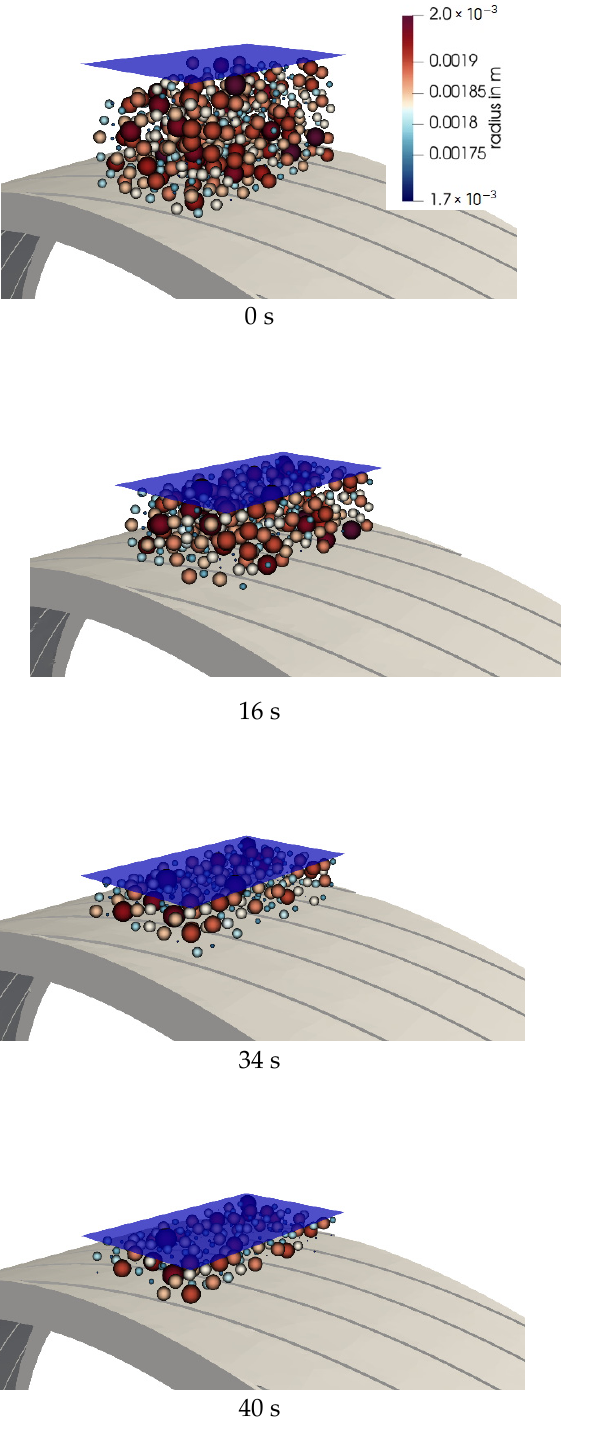
Figure 6. ( Left column ) particle radius shrinks and stamp compresses particles during melting in the DEM domain; ( right column ) melt fraction formation in a prechamber in the CFD domain. Rotational speed: 3 min − 1 ; simulation time: from 0 to 40 s.